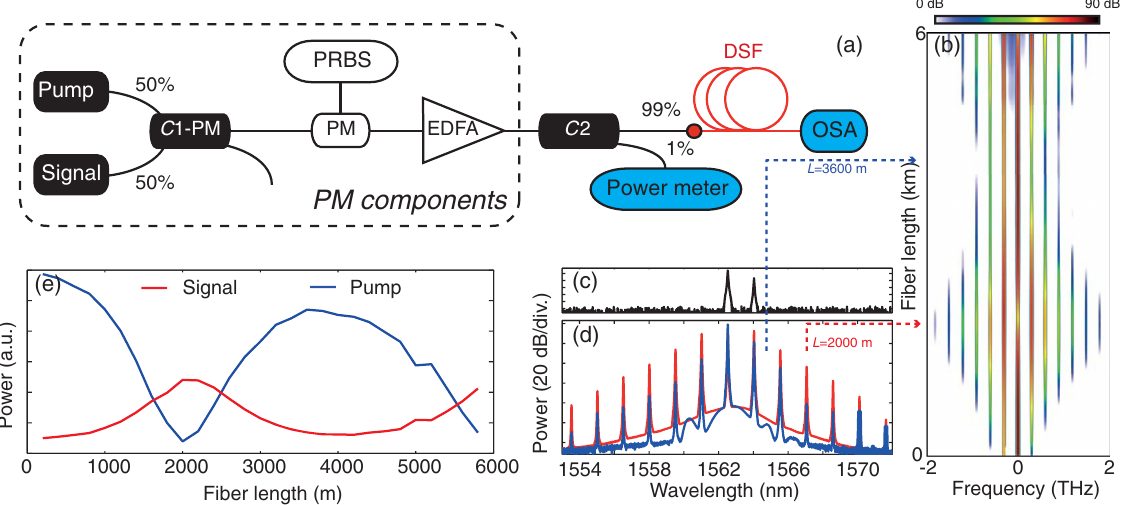
FIG. 1 (a) Experimental setup. Notations are as follows: C 1 ; 2 are optical couplers; PRBS, pseudorandom bit sequence; PM, phase modulator; and OSA, optical spectrum analyzer. Experimental data: (b) Evolution of the spectrum versus fiber length. Spectra at specific lengths at (c) L ¼ 0 m and (d) L ¼ 2000 m (red line) and L ¼ 3600 m (blue line). (e) Evolution of the pump and signal powers versus fiber length. All these experimental results have been obtained with a second-order-dispersion value β 2 ¼ − 1 . 116 × 10 − 27 s 2 = m (11.7 nm above the fiber